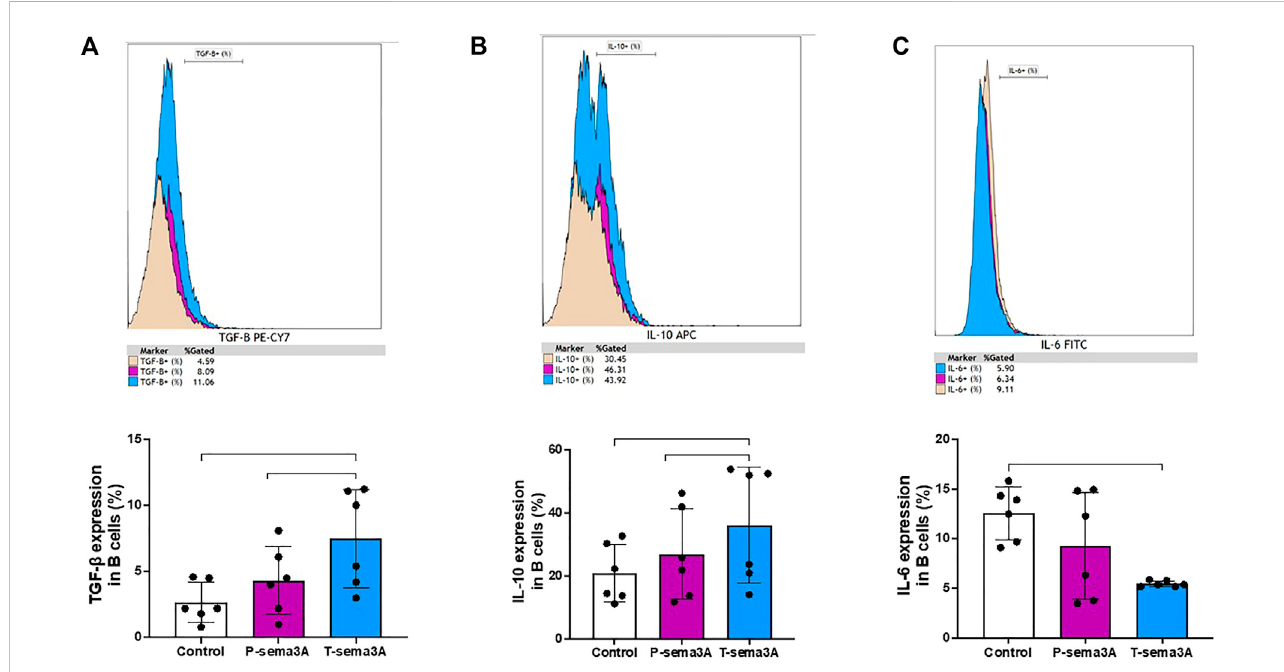
FIGURE 6 Truncated sema3A induces regulatory pattern in B lymphocytes. CD22 + B cells were isolated from PBMCs using MACS microbeads and MS column. The positively isolated B cells were cultured in 12-well plates and activated with 1 µM TLR9 agonist-CpG-ODN and 5 μ g/mL CD40L at 37 ° C for 24 h. After 24 h, 1 μ g/mLofP-orT-sema3Aortheappropriateamountofacontrolelutionbufferwasaddedforanadditional24 hat37 ° C.Onthedayoftheexperiment,cells were stained with fl uorescence antibodies and the expression of the following cytokines was evaluated in a NAVIOUS EX fl ow cytometer. The results were analyzed using Kaluza software, and the statistical signi fi cance was calculated using one-way ANOVA and Friedman test (*= p -value < 0.05 and ** = p -value < 0.01). (A) . TGF- β 1 (B) . IL-10 (C) .